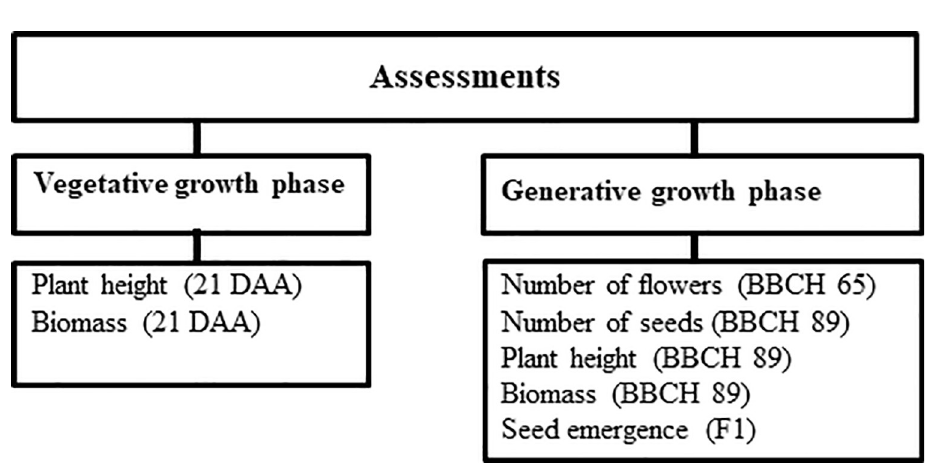
Fig 1. Assessments performed at the vegetative and generative growth stage of the plants (DAA = Days After Application).